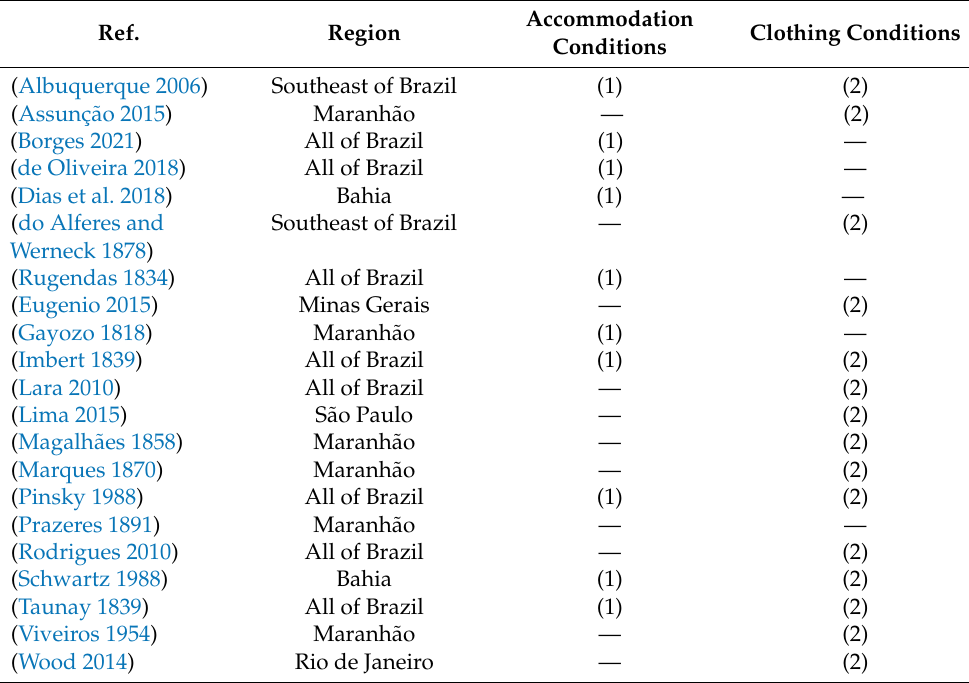
Table 1. Accommodation and clothing conditions—19th century. Ref.